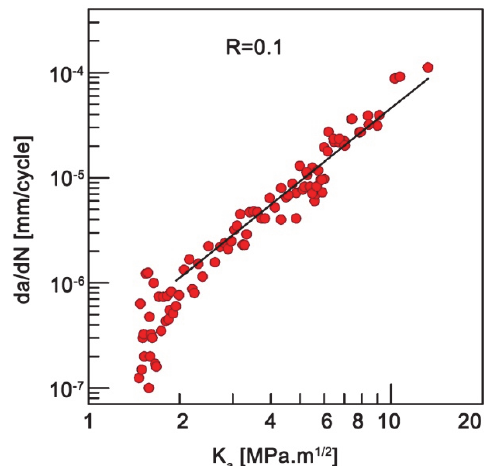
Figure 8: Fatigue crack growth data for SLM Inconel 718